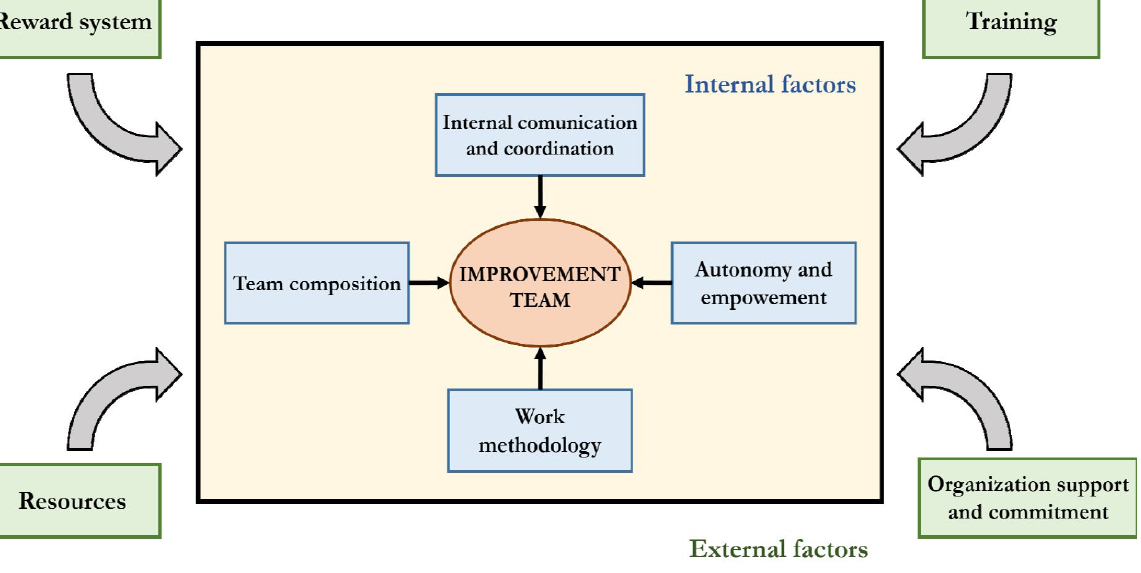
Figure 4. Critical factors in improvement teams design and